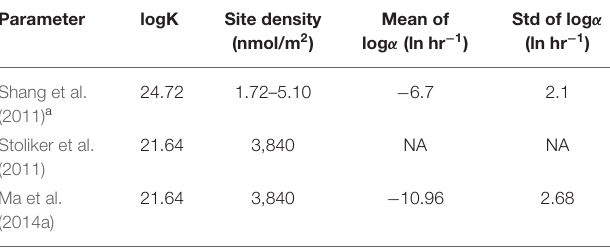
TABLE 2 | Summary of reaction parameters used in previous studies.